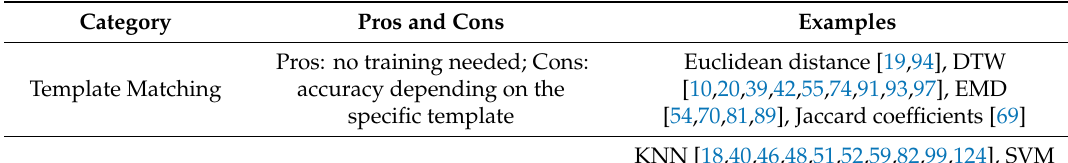
Table 8. Summary of the activity